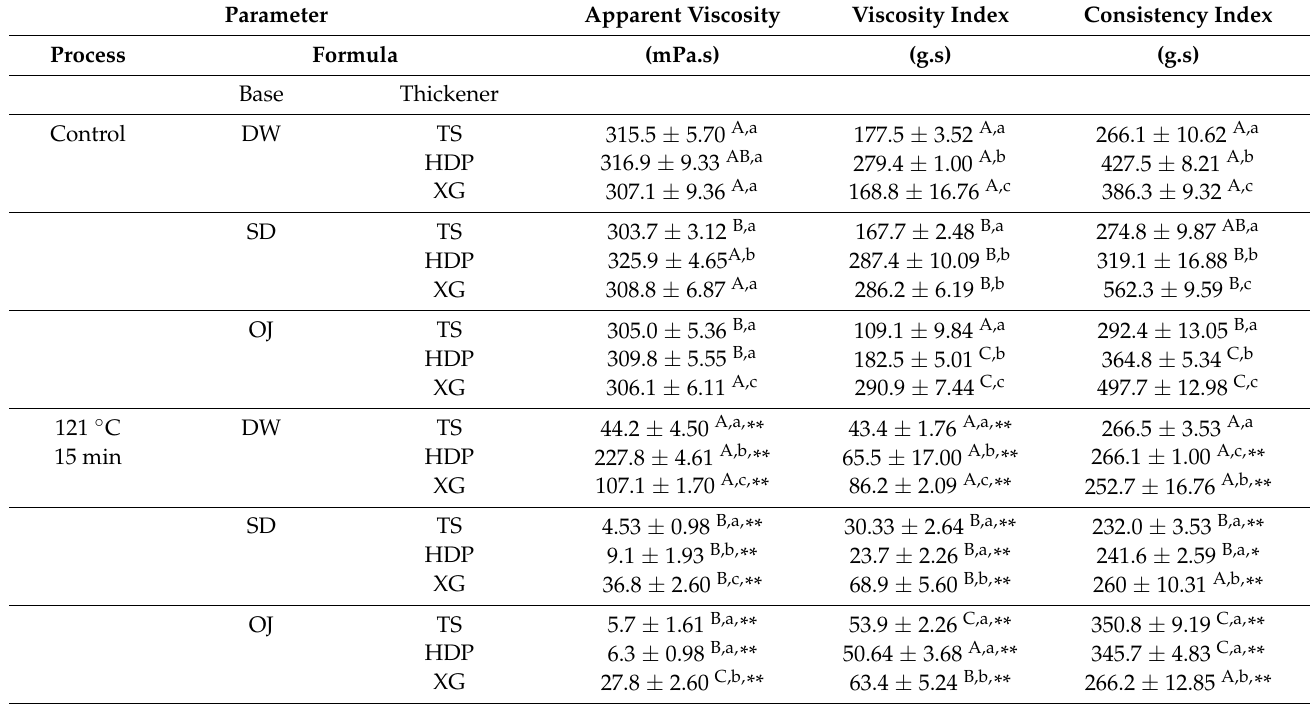
Table 7. Textural parameter variations due to thermal processing, aquatic continuous phases, and commercial thickeners after 28 days of storage at 4 ◦ C facilitated by a 121 ◦ C-15 min thermal process.